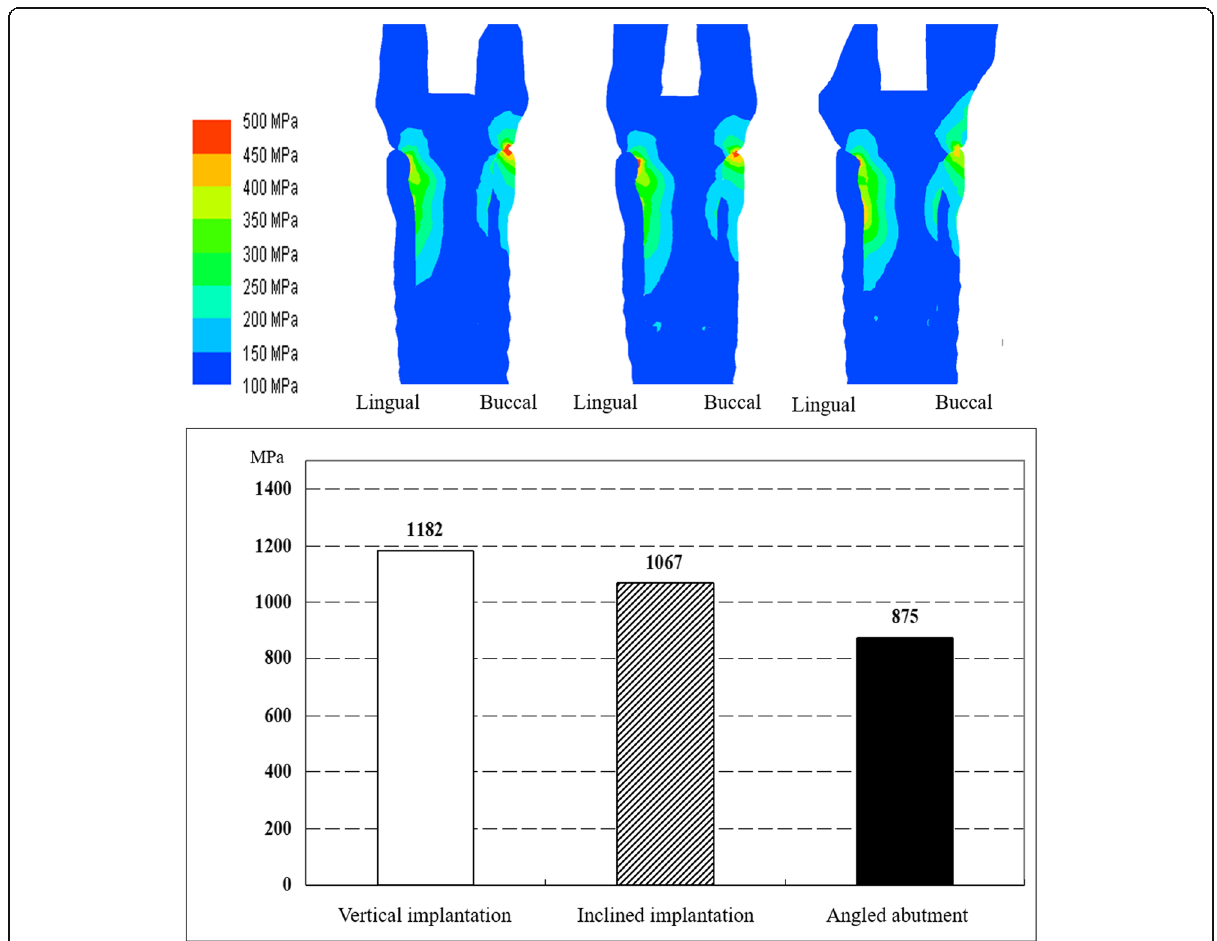
Fig. 17 Comparison of the maximum stress under 60° loading in vertical implantation, inclined implantation, and angled abutment